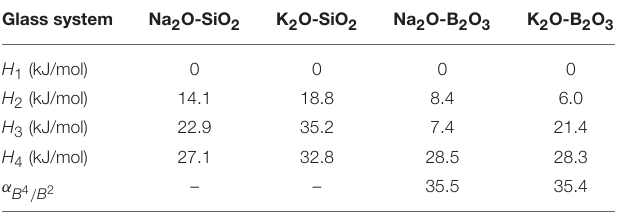
TABLE 1 | Relative association enthalpies ( H i ), where i corresponds to a given structural configuration, for the fitting of the current statistical mechanical model to experimental structure data.